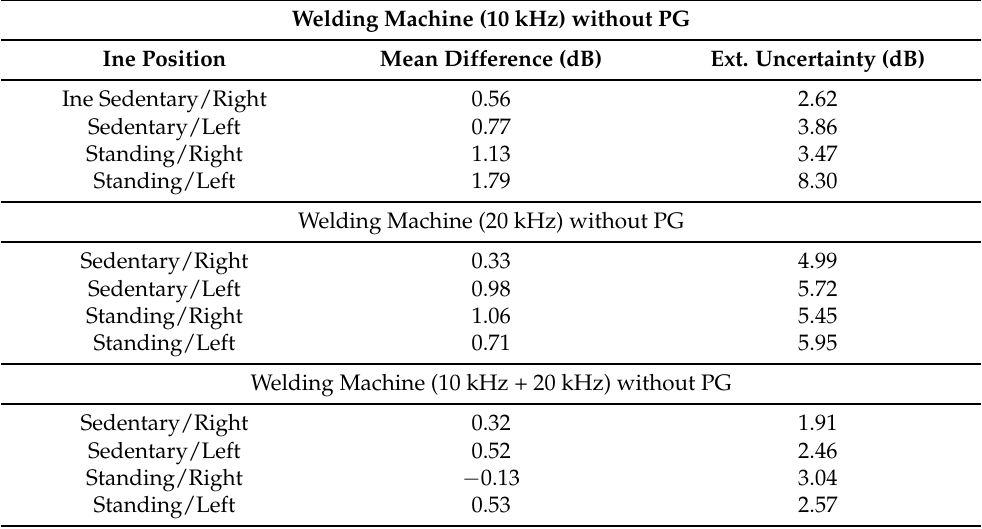
Table 1. Mean difference between the HiFUSPEx and the USPM together with the extended measure- ment uncertainty calculated for each simulated scenario of the idealized set-up of a welding machine. Measurements performed with no protection grid (PG) mounted on the microphone cartridge.